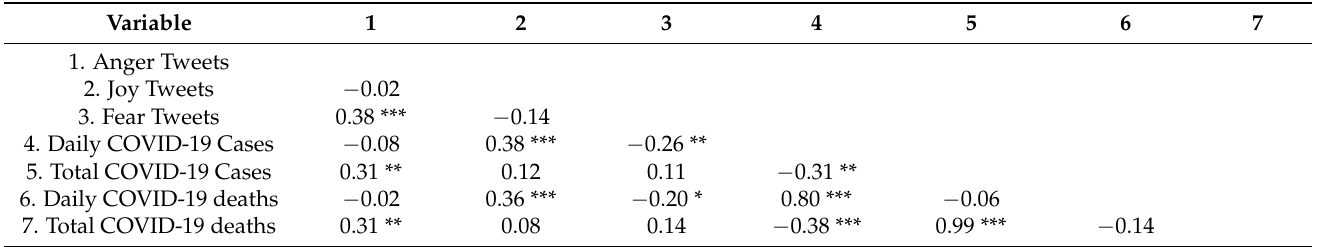
Table A3. Turin Pearson’s correlation coefficient